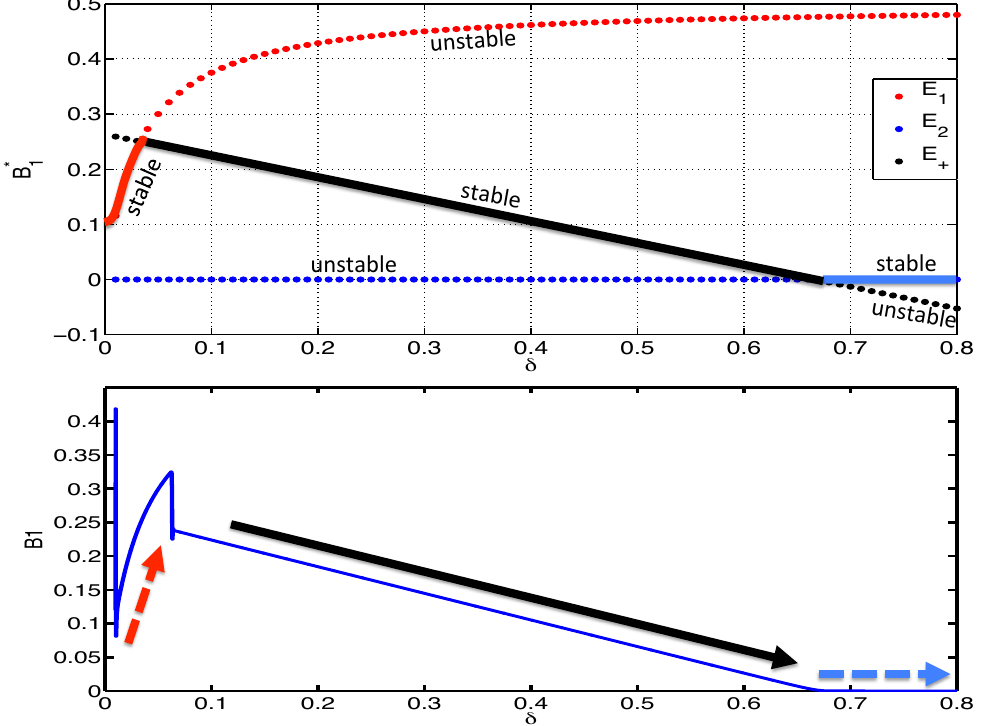
Figure 7. ( A ) Steady state solutions of bad bacteria ( B ∗ ) as a function of δ corresponding to E 1 1 (red), E 2 (blue) and E + (black) equilibria, respectively. Solid curve = stable, dotted curve = unstable. Green arrows indicate the points δ = 0.0033,0.35,0.7 corresponding to Figure 6A–C, respectively. ( B ) Trajectories of B 1 ( t ) in a B 1 − δ plane when δ is a monotonic increasing function of time, satisfying d δ = 0.00002 with the initial condition B ( 0 ) = 0.12, B ( 0 ) = 0.01, A ( 0 ) = 0, δ ( 0 ) = 0.01 near the E 2 1 dt stable equilibrium point E 1 = E 1 ( δ = 0.01 ) . As δ is increased, the system sequentially follows the stable branches in (A), leading to the transition from stable E 1 branch (red solid curve in (A)) to stable E + branch (black solid curve in (A)) and then to stable E 2 branch (blue solid curve in (A)). All other parameters are fixed as in Table 4 (Type